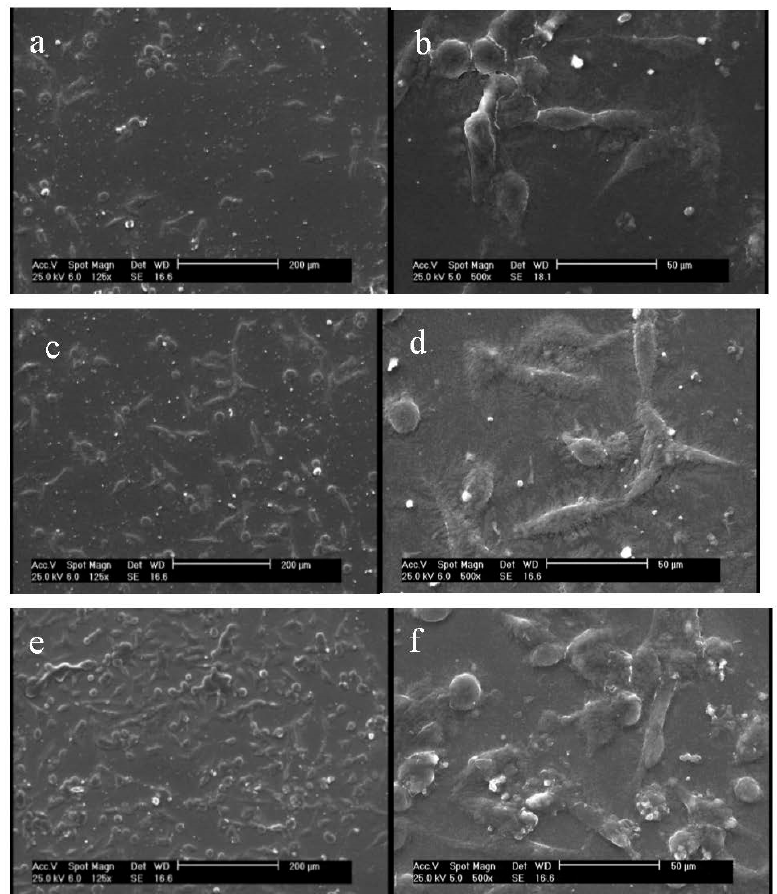
Figure 5. SEM images of cultured fibroblast cells on the gelatin films: ( a ) cells on the untreated gelatin film at × 125, ( b ) cells on the untreated gelatin film at × 500, ( c ) cells on the argon plasma treated gelatin film at ×125, ( d ) cells on the argon plasma treated gelatin film at ×500, ( e ) cells on the argon–oxygen plasma treated gelatin film at ×125 and ( f ) cells on the argon–oxygen plasma treated gelatin film at ×500.